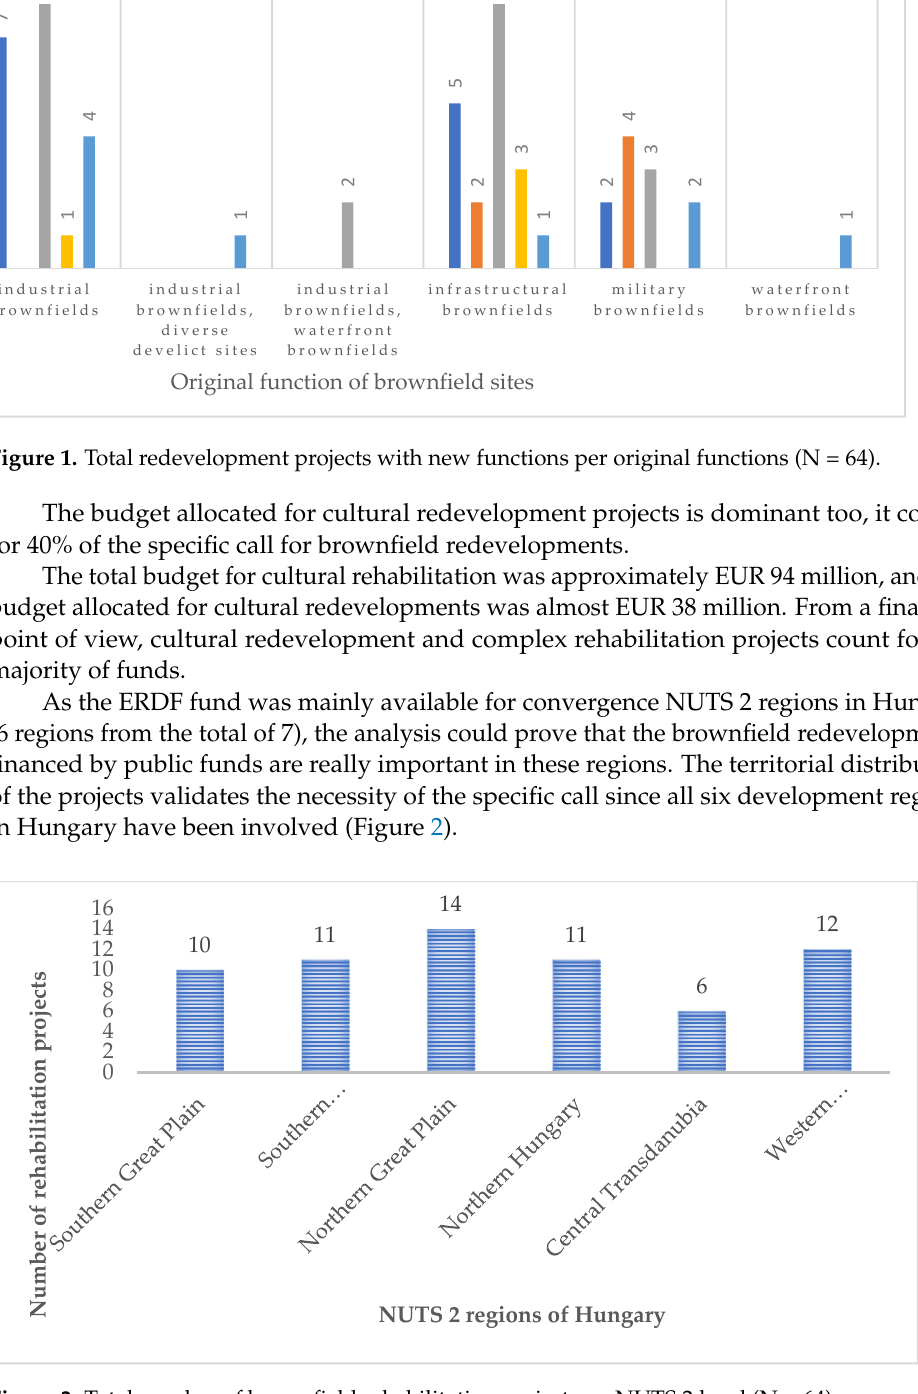
Figure 3. Rehabilitation types on NUTS 2 level (N = 64). Table 3. Redevelopment projects for diverse derelict sites. Develop- ment Region (NUTS 2)